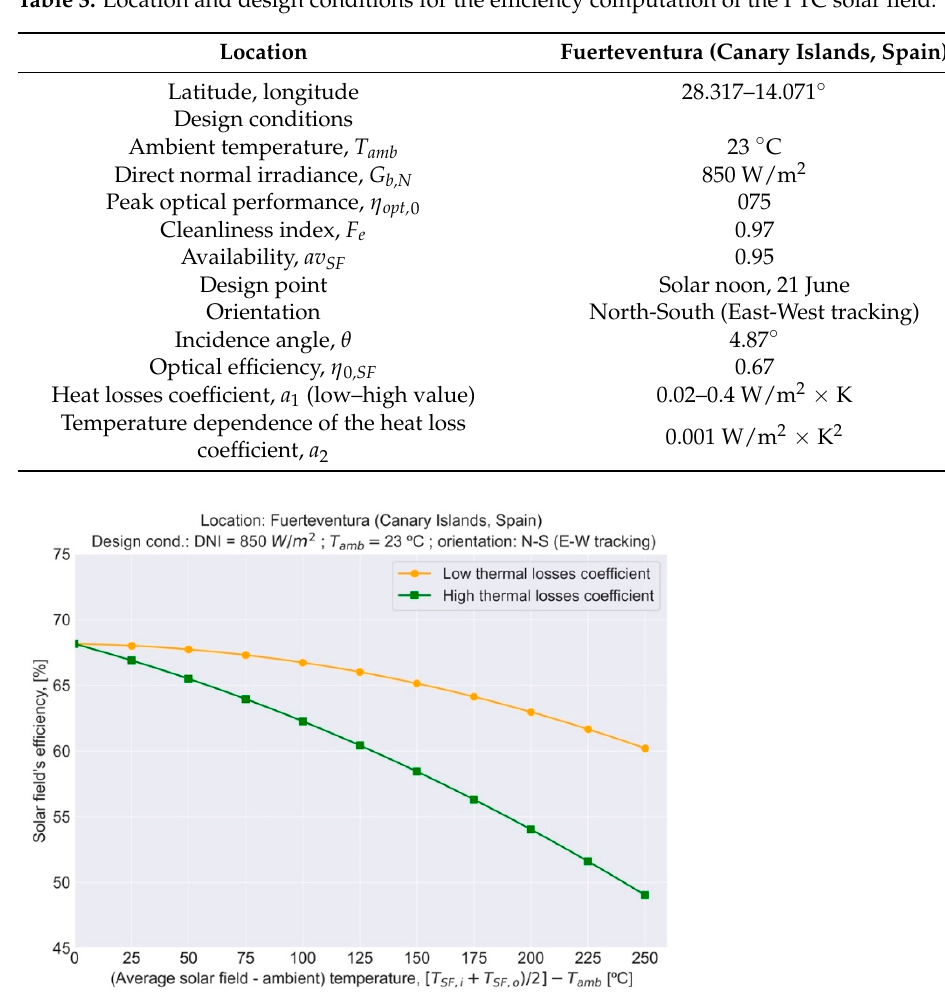
Table 3. Location and design conditions for the efficiency computation of the PTC solar field.